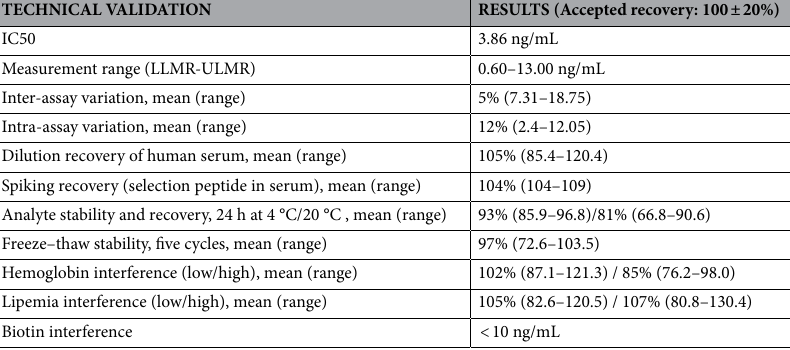
Table 2. Summary of technical parameters for